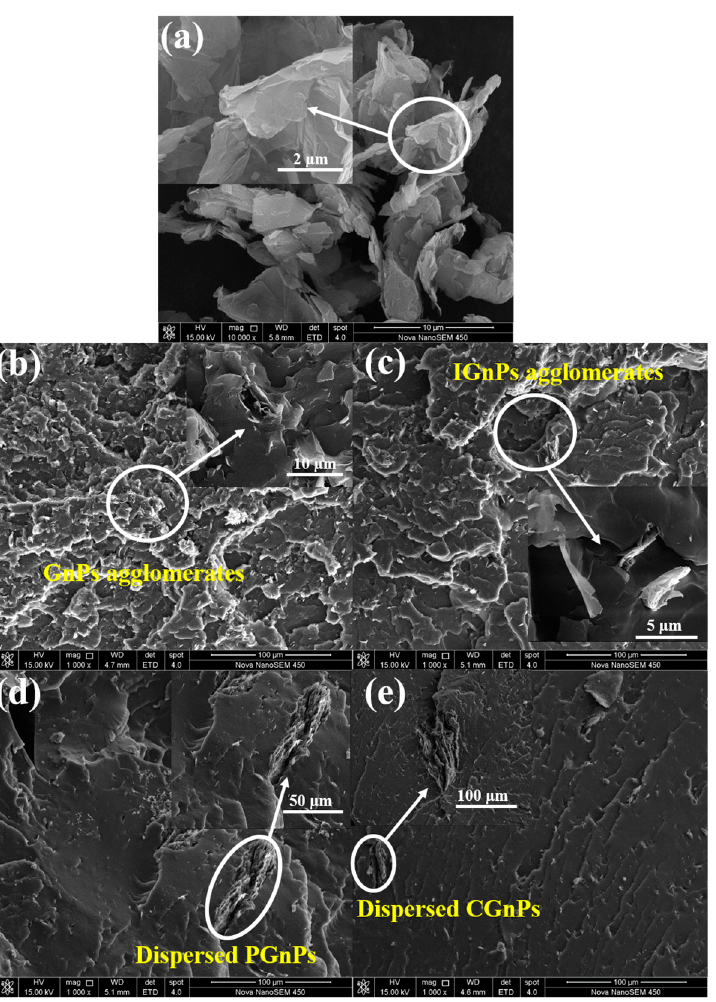
Figure 6. FE-SEM images of ( a ) GnPs and the fracture surfaces of ( b ) TPU/GnPs, ( c ) TPU/IGnPs, ( d ) TPU/PGnPs and ( e ) TPU/CGnPs filaments.